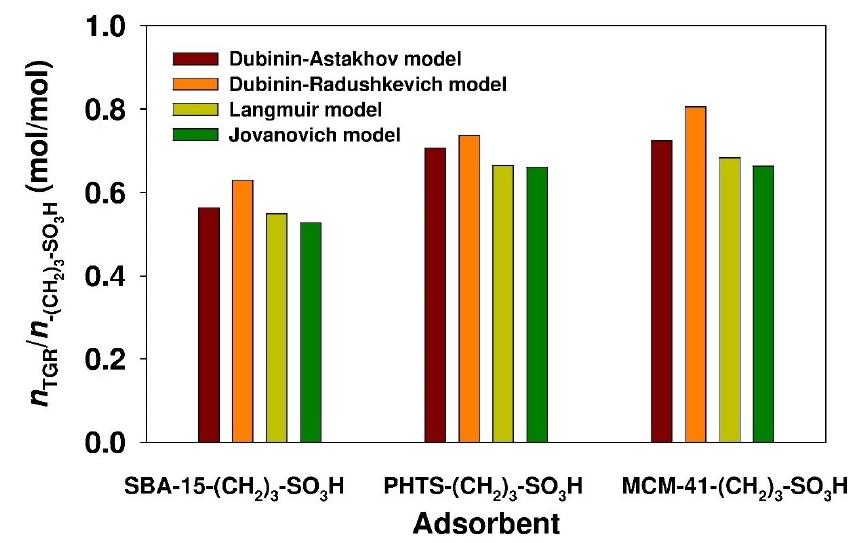
Figure 8. Molar ratio of ticagrelor molecules to propyl-sulfonic acid group content based on Q ads ( max ) value parameter calculated from non-linear fitting analysis.